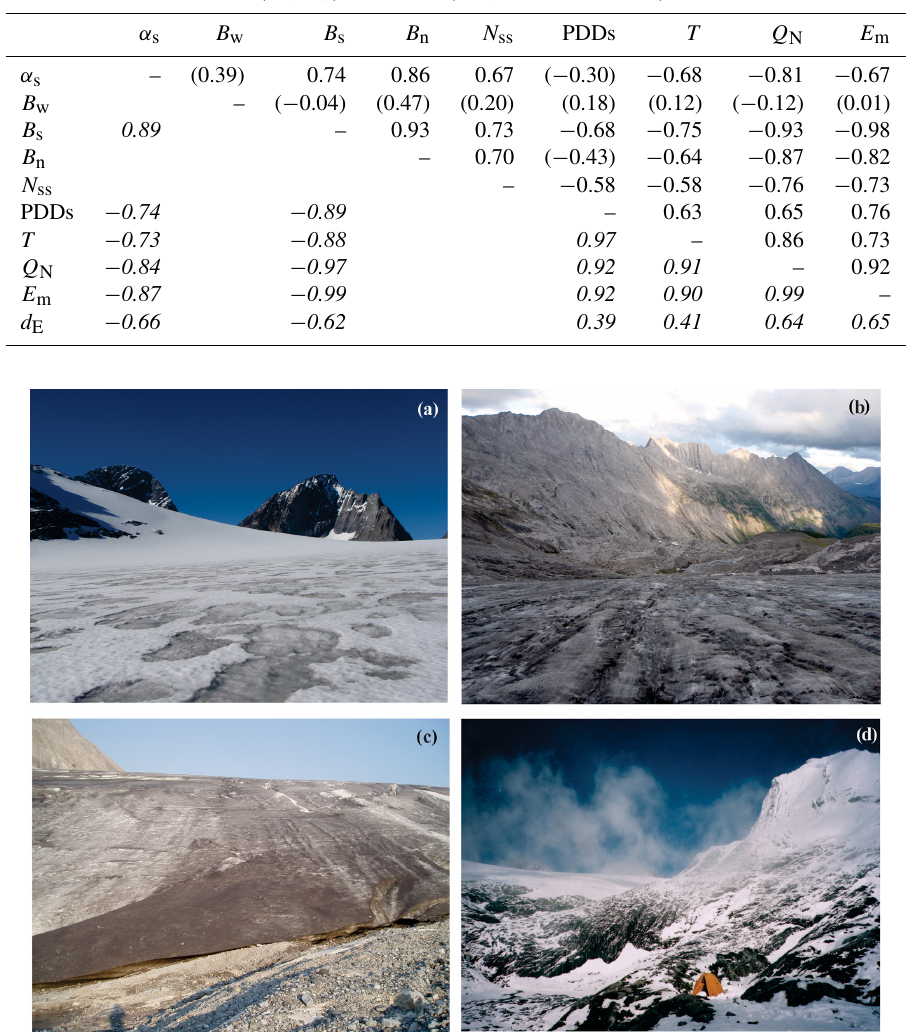
Figure 4. Photographs of the Haig Glacier, illustrating the variability of summer surface cover. (a) The transition from seasonal snow to exposed glacier ice. (b) Meltwater runnels looking downslope in the ablation area, illustrating the heterogeneous but extensive concentration of surface impurities. (c) Dark ice at the glacier terminus. (d) Fresh snow covering the glacier after a heavy August snowfall. Photos by Shawn J.